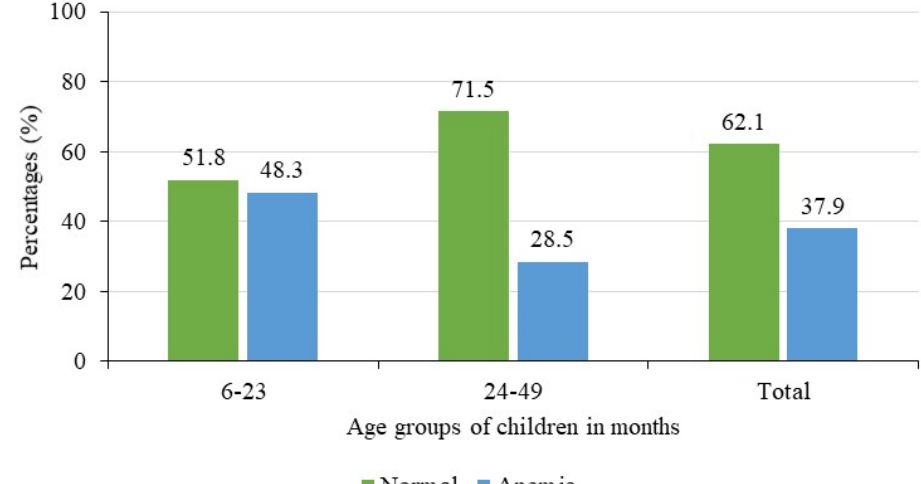
Figure 3. Prevalence of anemia by age groups of children in months (N=602).